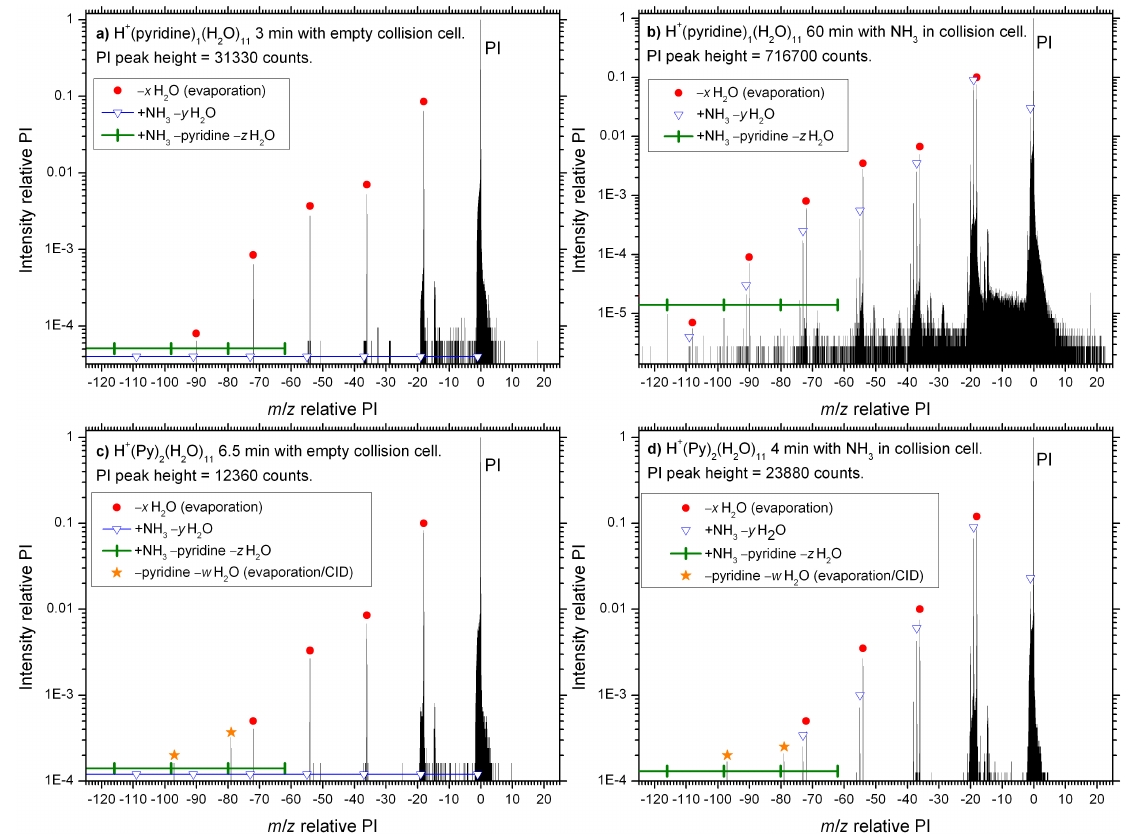
Fig. 3. Mass spectra of H + (pyridine) m (H 2 O) 11 with peak intensities expressed relative to the parent ion (PI) mass and height. (a) m = 1, background measurement. (b) m = 1, the cluster ion reacting with NH 3 at 8kJmol − 1 . (c) m = 2, background measurement. (d) m = 2, the cluster ion reacting with NH 3 at 8kJmol − 1 . The product H + (NH 3 ) 1 (pyridine) 1 (H 2 O) 11 − y peaks are designated by open blue triangles. Red circles designate peaks arising from evaporation of H 2 O from the parent ion. Green vertical lines designate the m/z where a possible NH 3 /pyridine exchange product, H + (NH 3 ) 1 (H 2 O) 10 − z , would appear. Loss of pyridine without exchange for NH 3 is designated by orange